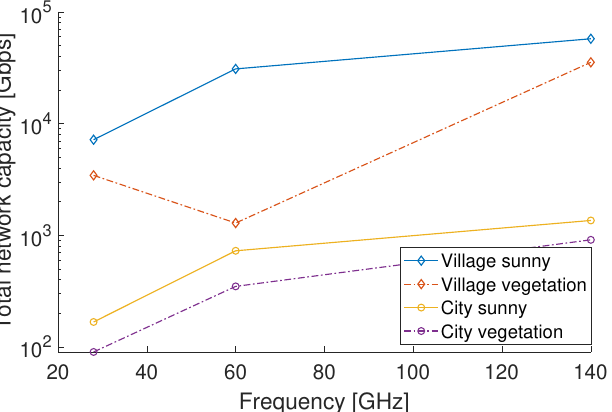
Figure 5. Averaged total network capacity as a function of carrier frequency for a village and city environment, with 300 network subscribers in an area of 1 km 2 .